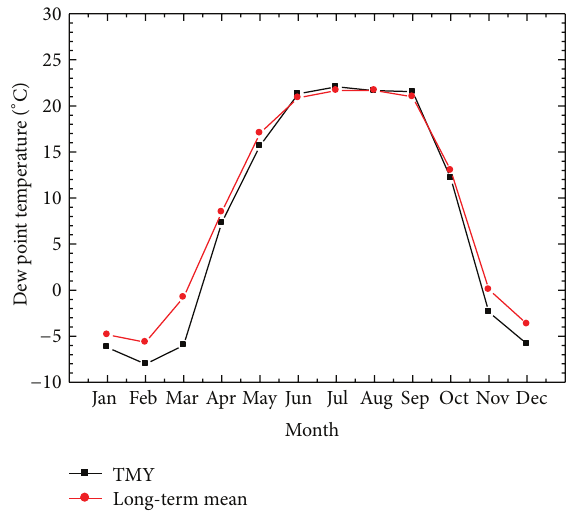
Figure 5: Predicted TMY with long-term average values for the dew point